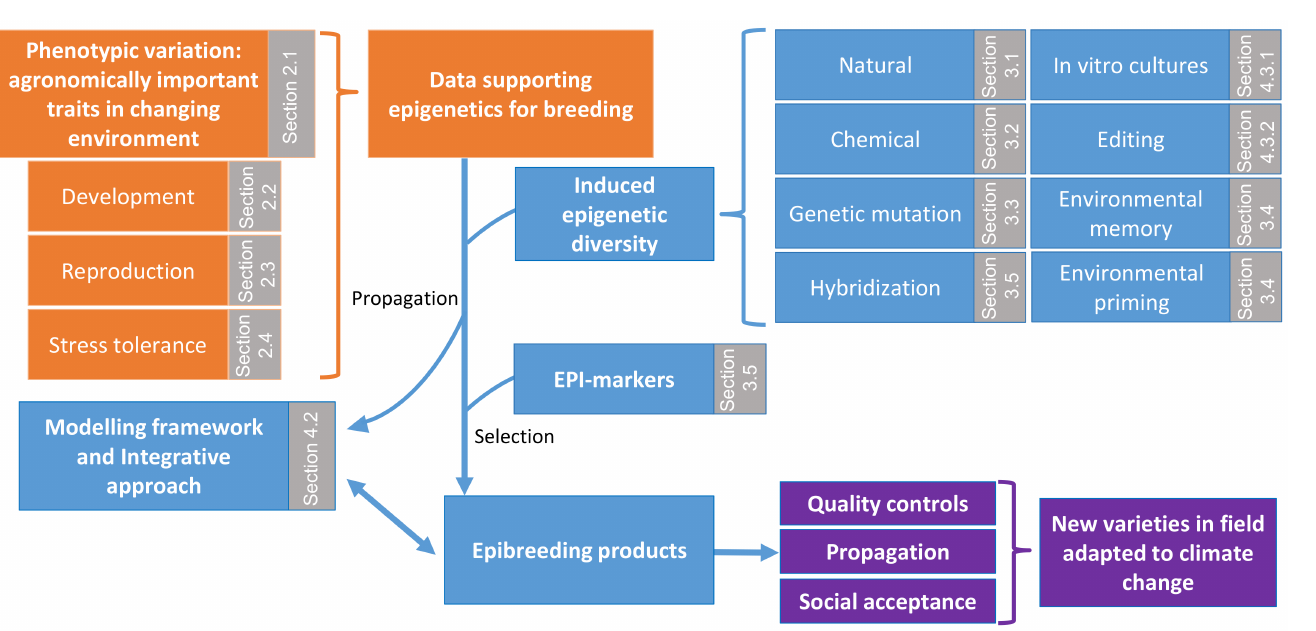
Figure 1. How the development of epigenetic data and tools will lead to epi-bred crops and new varieties in the field adapted to climate change. Section to find each topic in the review is indicated. In brown are indicated data already supporting epigenetics for breeding, in blue the uses of epigenetics for crop improvement (actually under development), and in purple the post-production steps until new varieties in the field (future